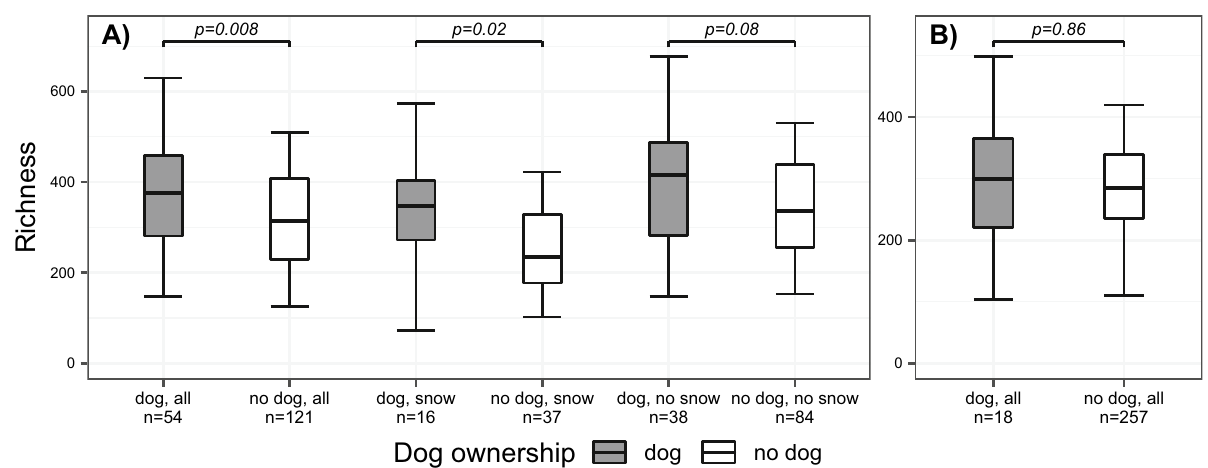
80.0=p20.0=p800.0=p A)